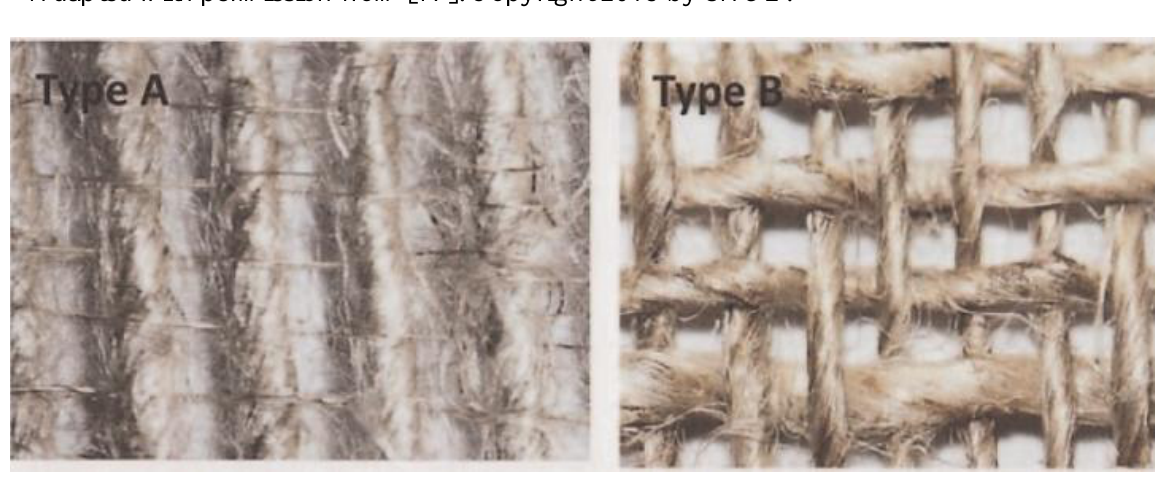
Figure 11. Weave architecture types: ( A ) plain; ( B , C ) two different twill; and ( D ) dobby [75]. Adapted with permission from [17]. Copyright 2013 by